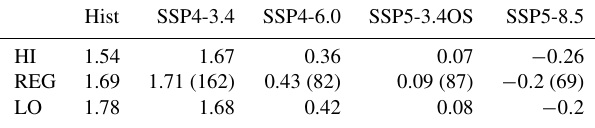
Table 4. Annual net LULCC flux [PgCyr − 1 ] in 2014 for historical simulations (Hist) starting in 1700 and in 2099 for four SSP scenar- ios. For the REG experiments, the cumulative net LULCC flux of the future scenarios (2014–2099) is included in brackets